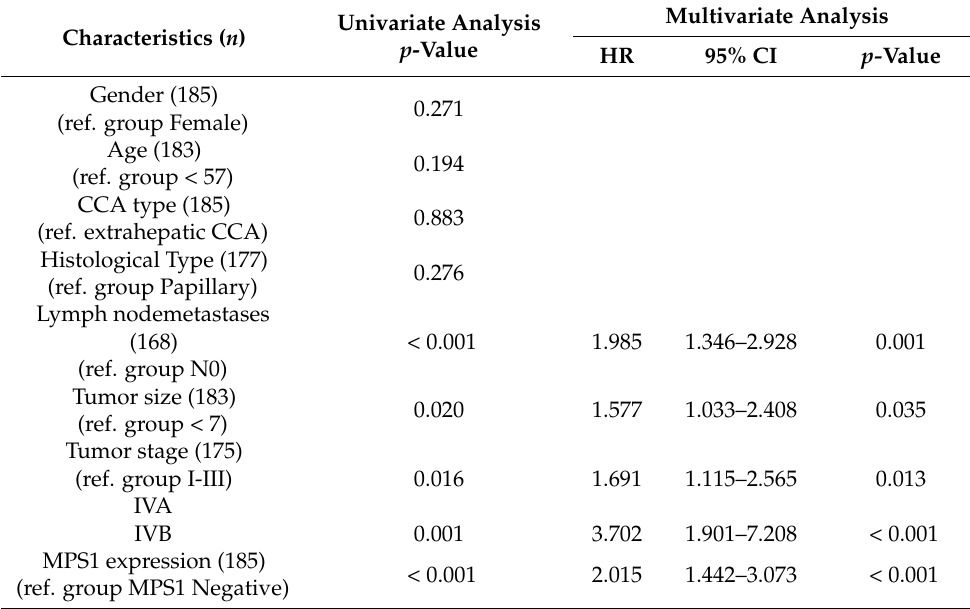
Table 2. Multivariate analysis of MPS1 expression in 185 CCA